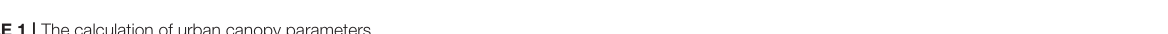
TABLE 1 | The calculation of urban canopy